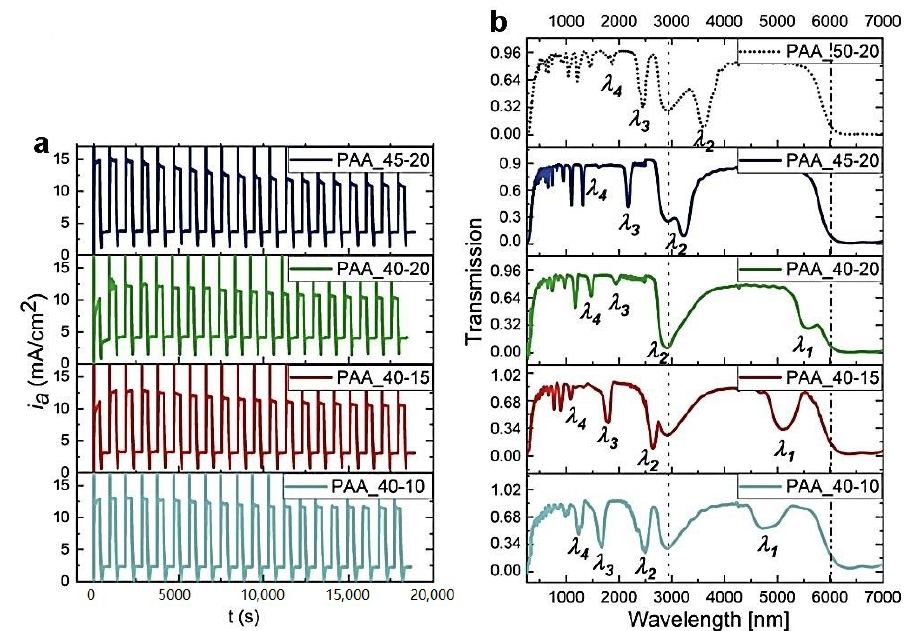
Figure 5. The i a ( t ) curves recorded during pulse anodization at 30 ◦ C under di ff erent U H and U L pulses [V] (PAA_U H -U L , other applied parameters: t H = 360 s, t L = 480 s, U H - > U L drop rate = 0.234 V / s, 20 cycles) ( a ) and the corresponding transmission spectra (the transmission spectra for the PAA_50-20 is taken from ref. [27] for comparison) ( b ).